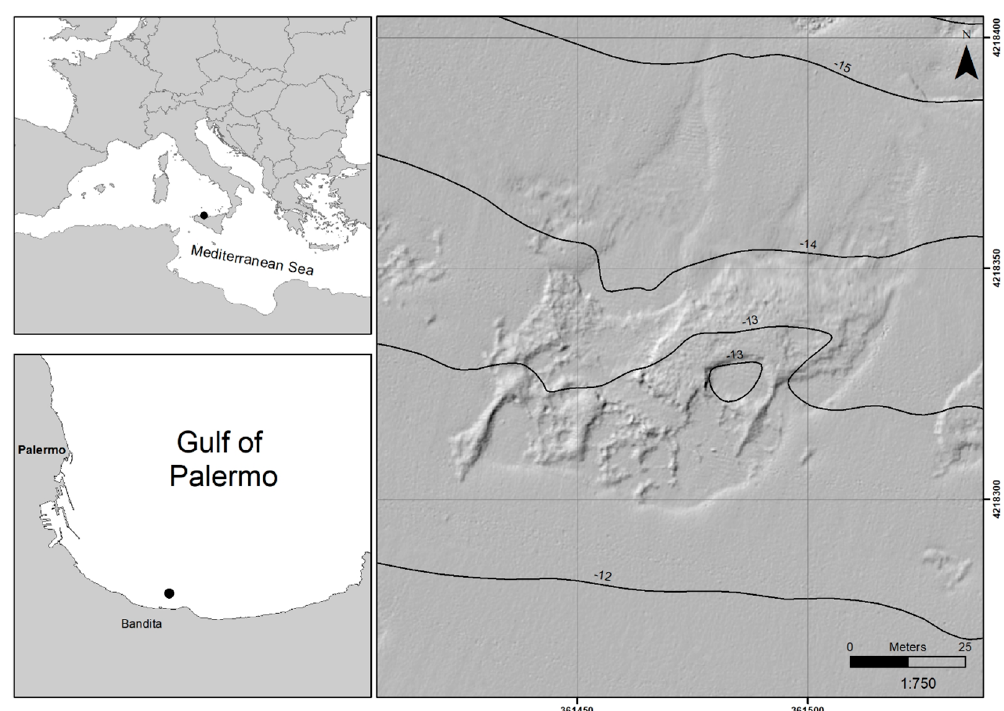
Figure 1. Study area. In relief on the right dead matte structures surrounded by sandy bottoms (39), detected by Multibeam Echosounder MBES survey near “Bandita” (Gulf of Palermo), where the P. oceanica restoration site is located [11]. The black dot in the lower left corner identifies the location of the area covered by the MBSS